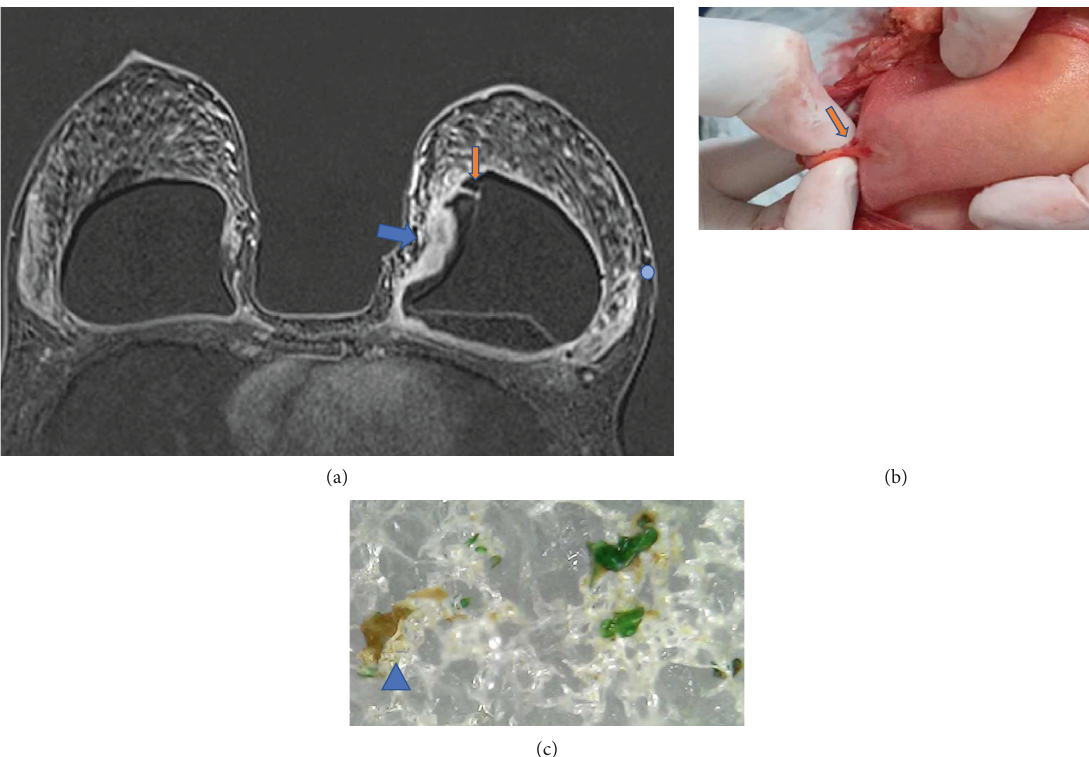
Figure 4: (a–c). Late contrast enhancement mass and a black-drop sign in a patient with polyurethane implant for 7 years. In the dynamic postcontrast T1-weighted sequence, the formation of an intracapsular mass (blue arrow) associated with a focus of marked low signal (black- drop sign) indicated by the blue circle. Macroscopy (b) shows intact implant with neovascularization in the implant surface (orange arrow). Microscopy of the implant surface (c) shows degradation of the surface, with fat inside the implant (blue triangle) and color change of the cohesive